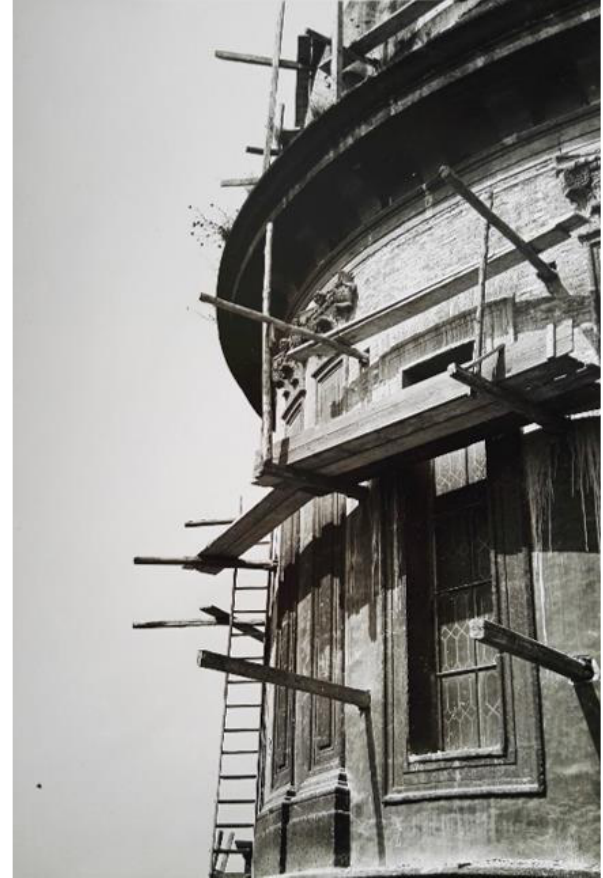
Figure 10. Santa Caterina a Formiello Church. In the upper part, the brick curtain of the drum (Archive Superintendence Archeologia, Belle Arti e Paesaggio per il Comune di Napoli (middle 20th